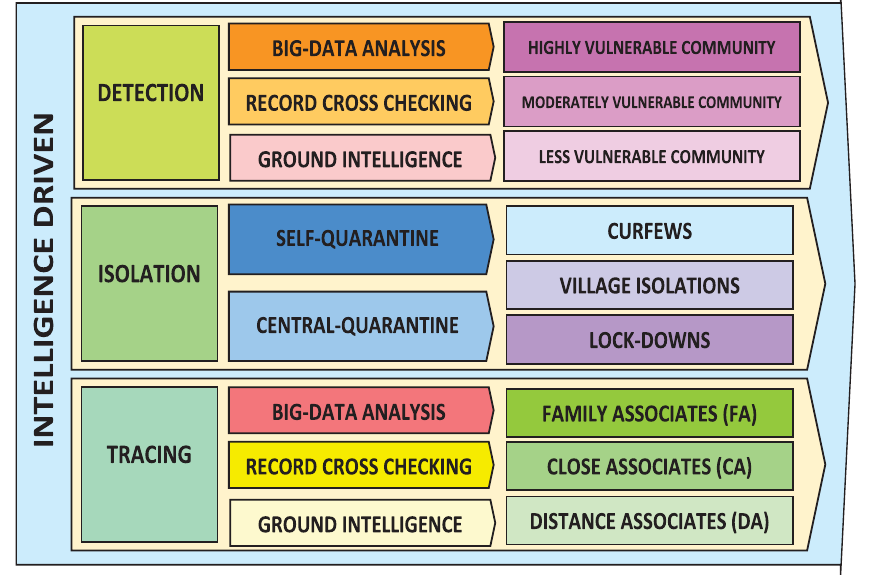
Figure 2: Detection, Isolation and Tracing (DIT) Model for mitigating the